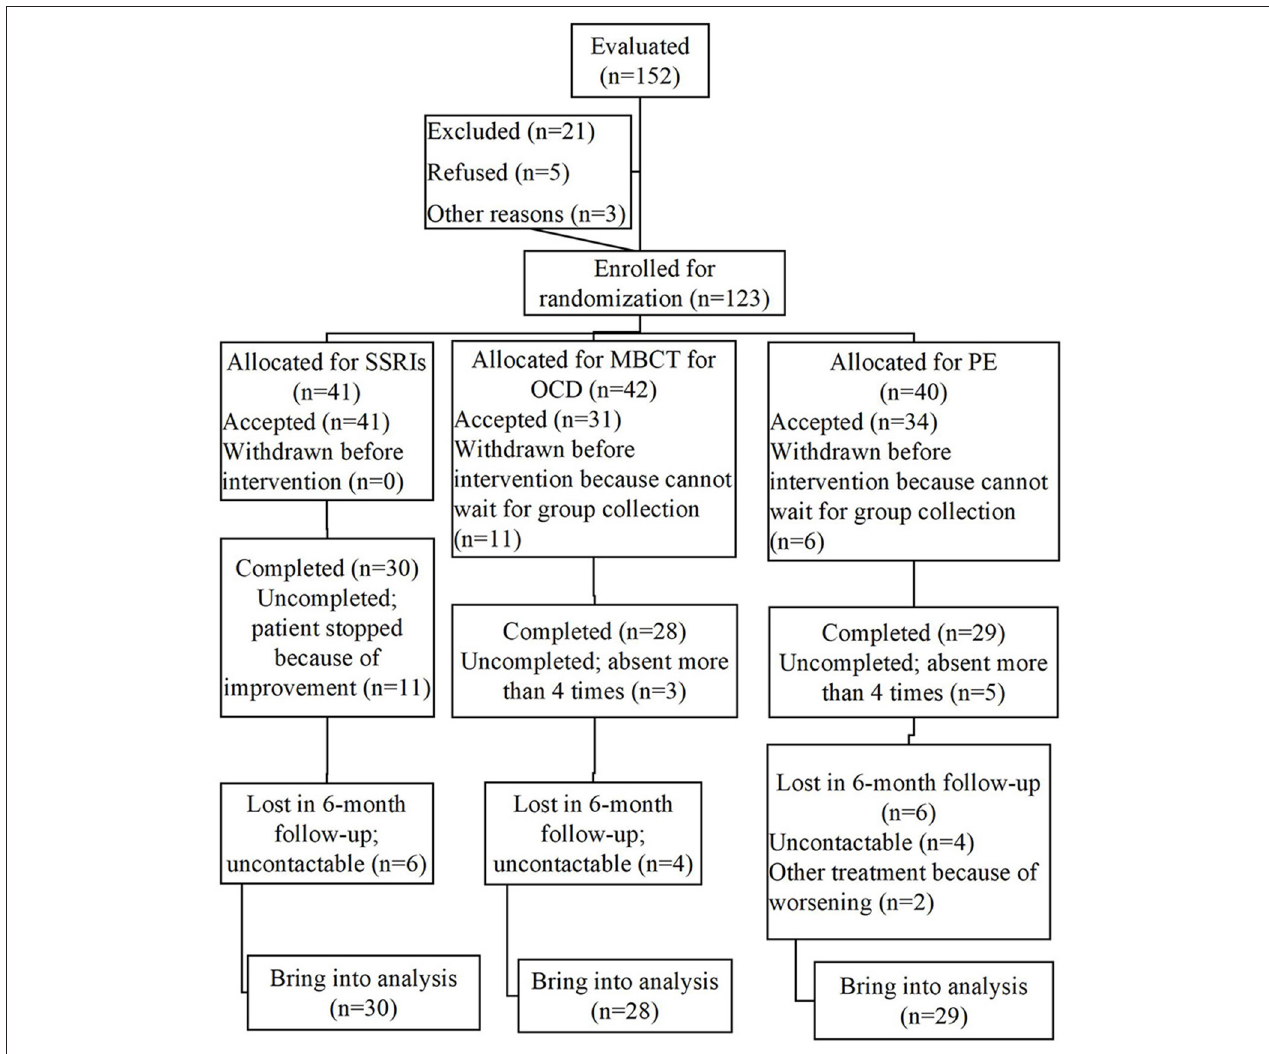
FIGURE 2 | CONSORT